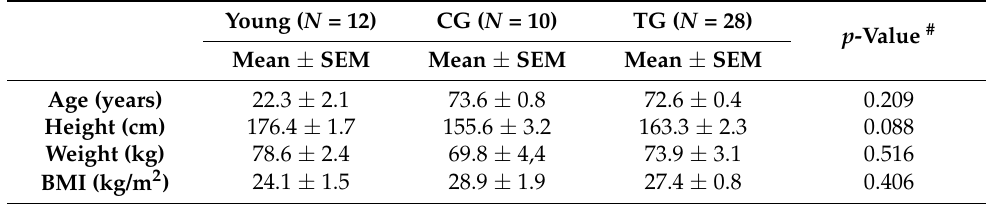
Table 1. Participant anthropometric characteristics.